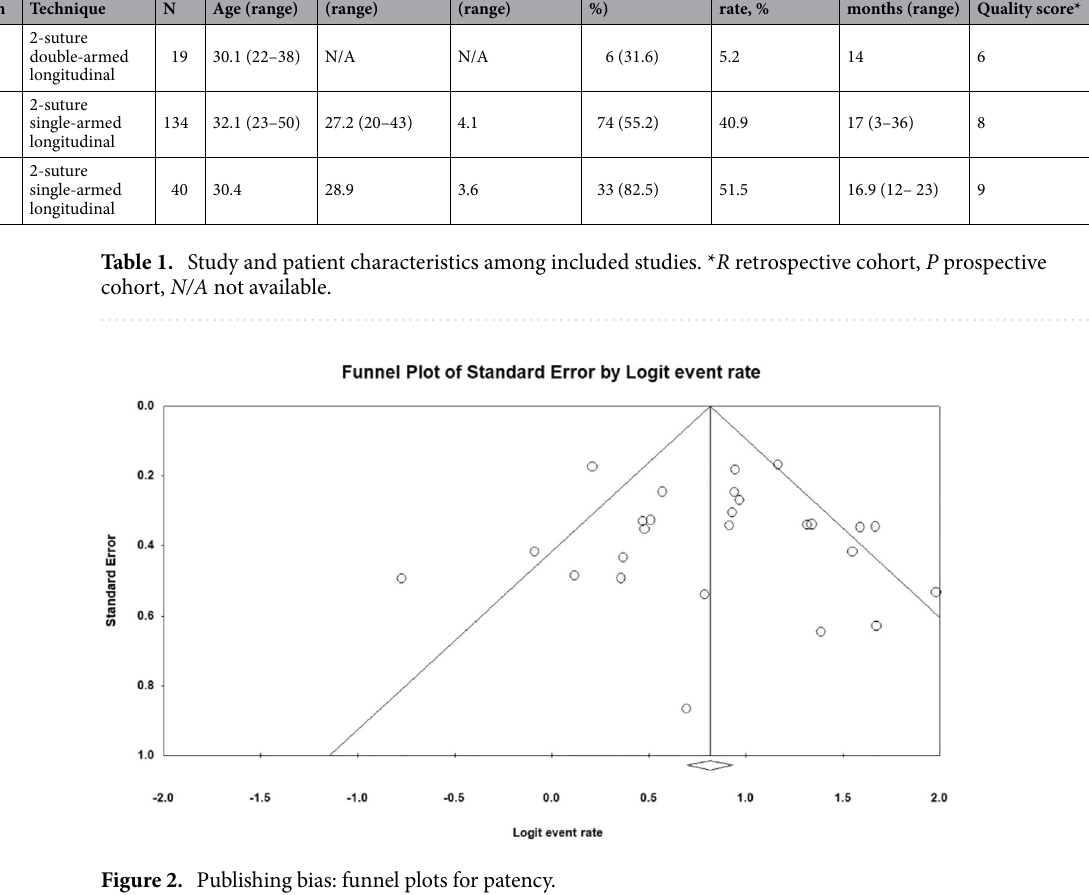
Figure 2. Publishing bias: funnel plots for